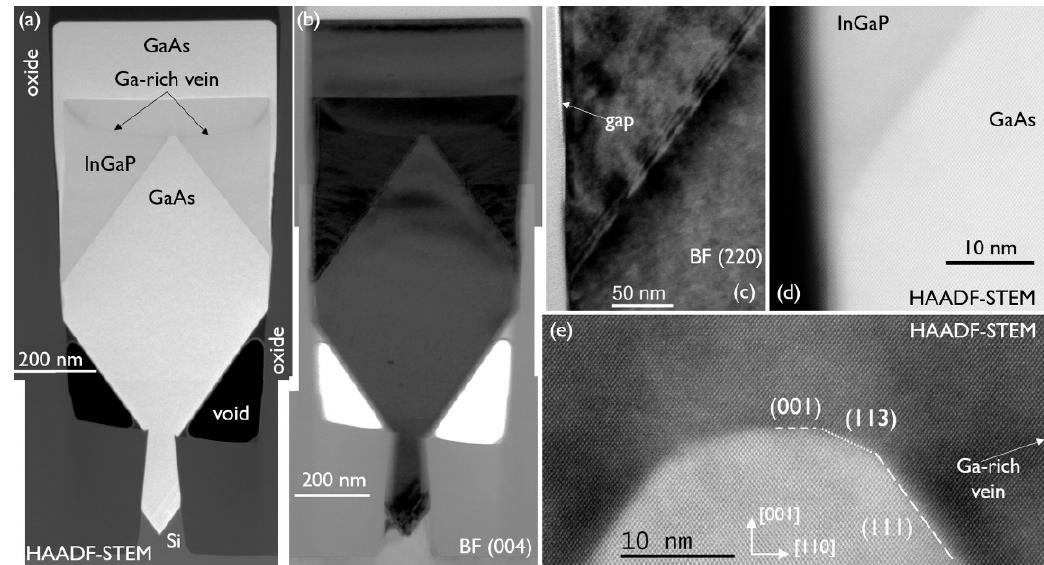
Figure 8. ( a ) HAADF-STEM and ( b ) BF (004) cross-section TEM image of a GaAs/InGaP/GaAs NR with a {111}-faceted starting GaAs NR. Zoom-in on the InGaP/GaAs interface at the oxide under ( c ) BF (220) and ( d ) HAADF-STEM conditions. ( e ) Zoom-in on the InGaP/GaAs interface at the tip of the {111}-faceted GaAs NR.